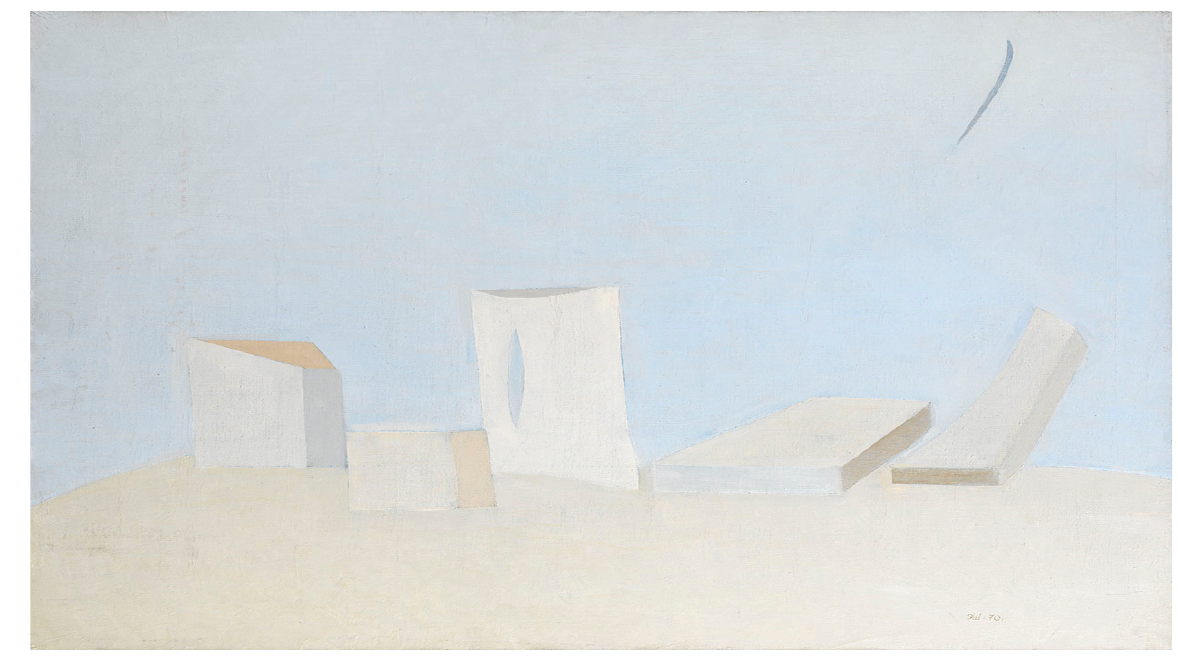
Figure 4. Eduard Steinberg. An abstract composition, 1970. Oils on canvas 80 * 100. Private collection, Switzerland. https://artinvestment.ru/auctions/2244/records.html?work_id=1164540 (accessed on 26 May 2022).